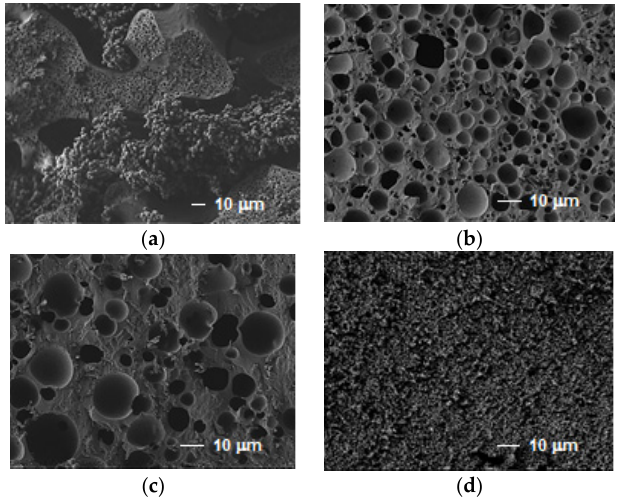
Figure 3. SEM images of AM4-HDA porous polymers Case II (feed molar ratio of AM4/HDA: 1/1), concentration and temperature ( a ) II-25w-40d, ( b ) II-25w-60d, ( c ) II-25w-80d, and ( d ) II-30w-40d.